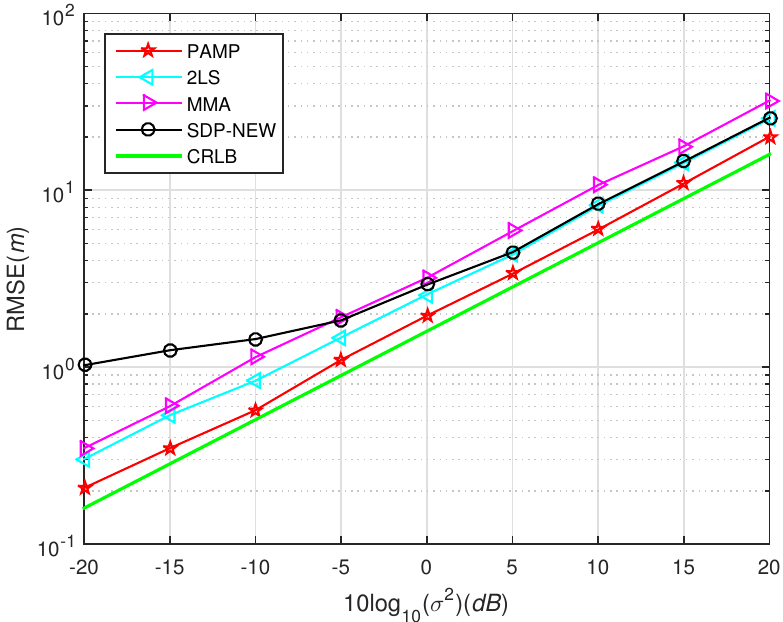
Figure 6. RMSE versus σ 2 using different methods in scenario 2, Gaussian